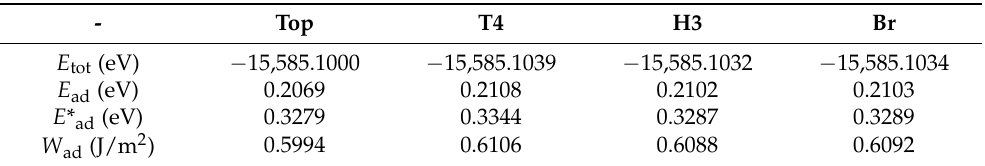
Table 3. A single Cu atom’s adsorption energy and adhesion work on different adsorption sites on a diamond (111)